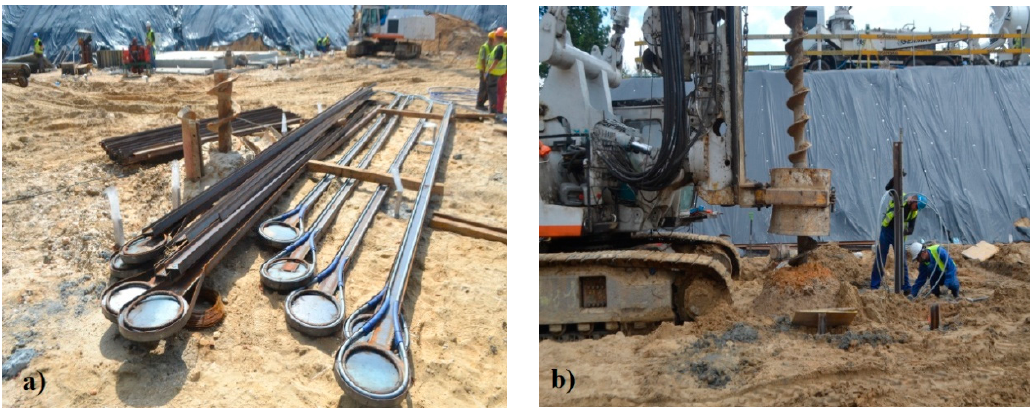
Figure 6. Execution of the energy piles in Krakow (the building of the National Archives), ( a ) reinforcement of the energy pile with an I-beam with a welded circular element, ( b ) execution of the energy pile.